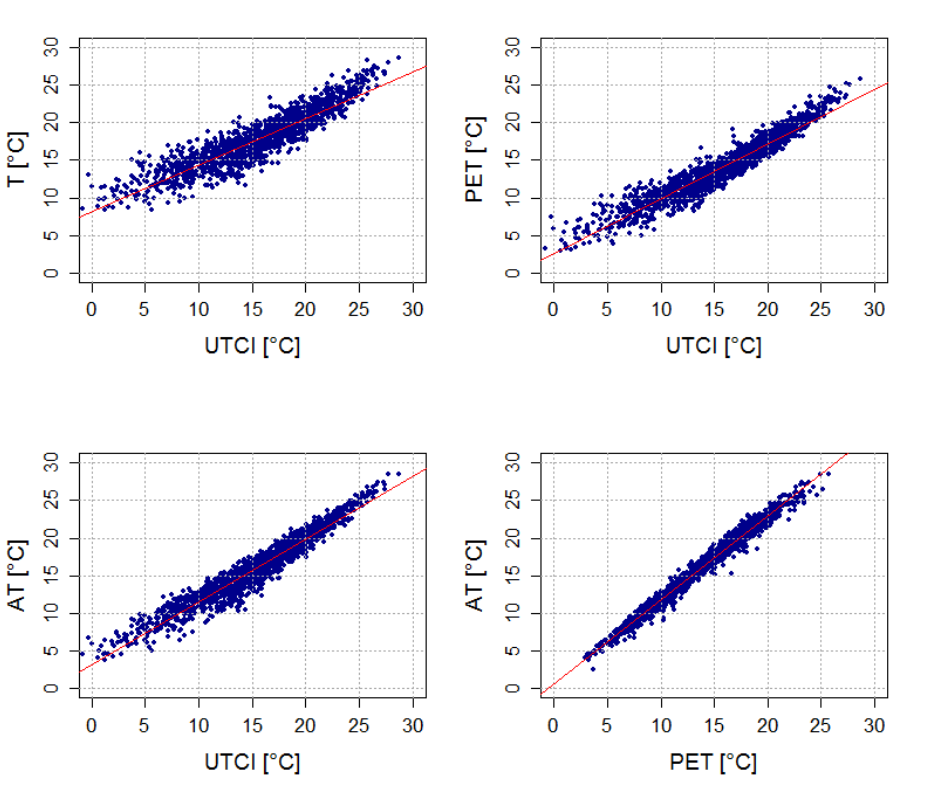
Figure 3. Linear regression between mean daily UTCI, PET, AT, and T in the urban (Prague) region in summer over 1994–2009. Coefficients of determination are shown in Table 3.